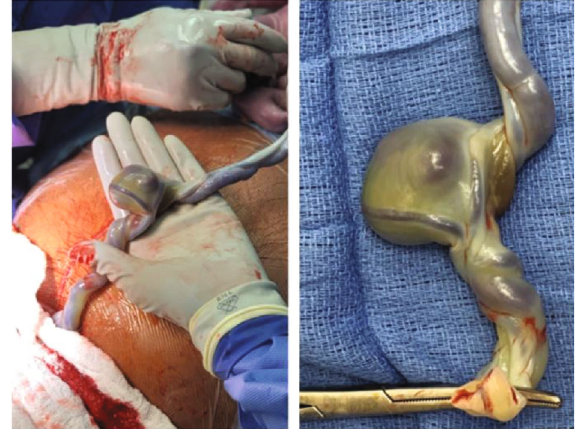
Figure 3: Gross specimen of the umbilical cord and umbilical cord